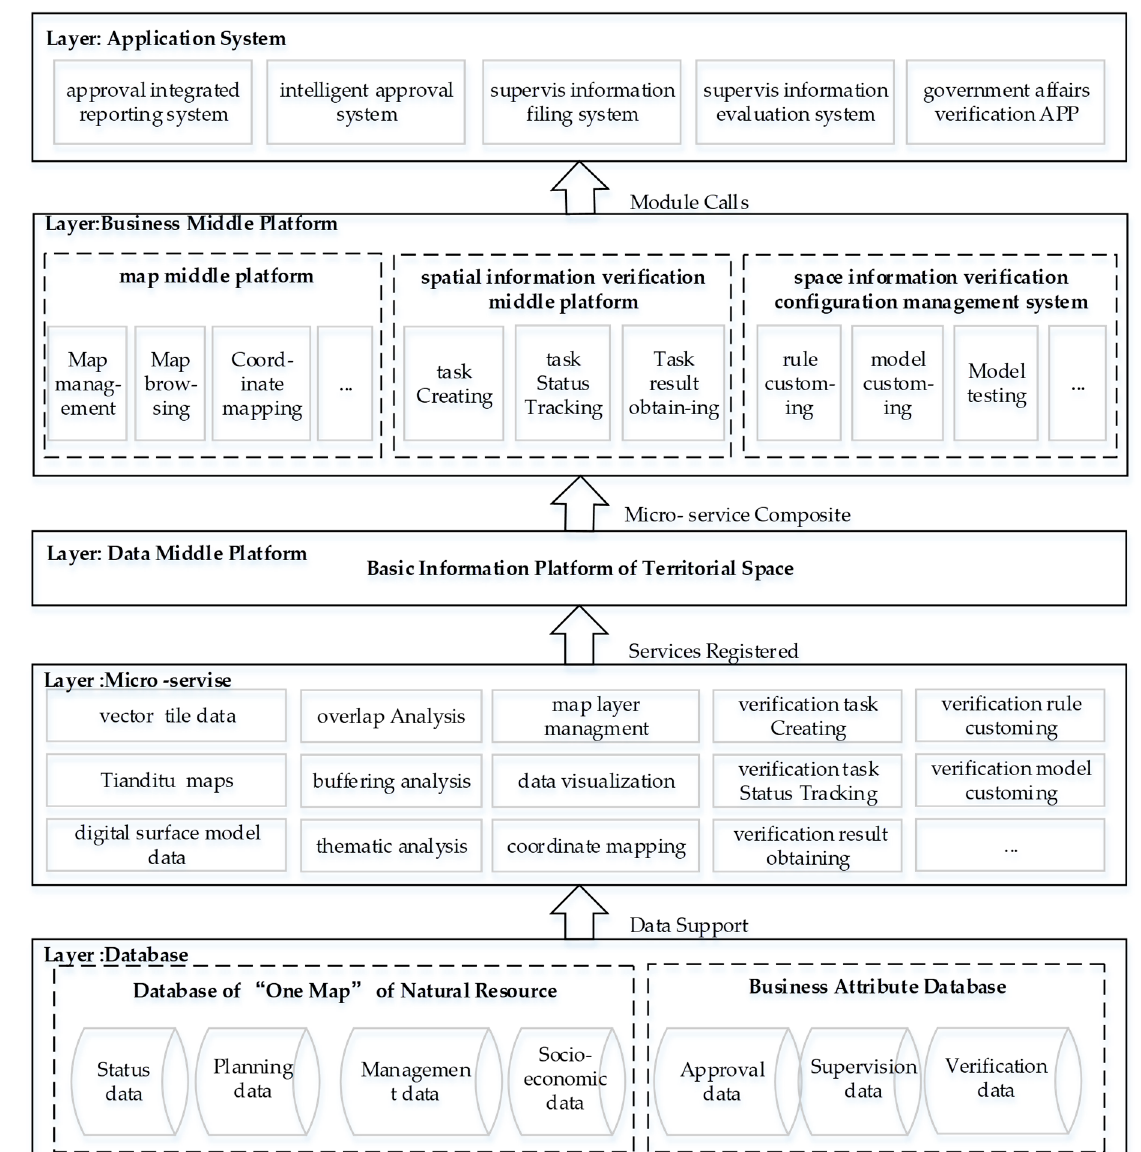
Figure 2. The architecture of geospatial information verification platform.